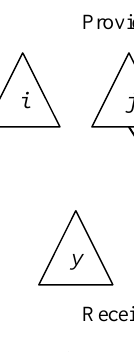
Fig. 3. Scheme of random policy